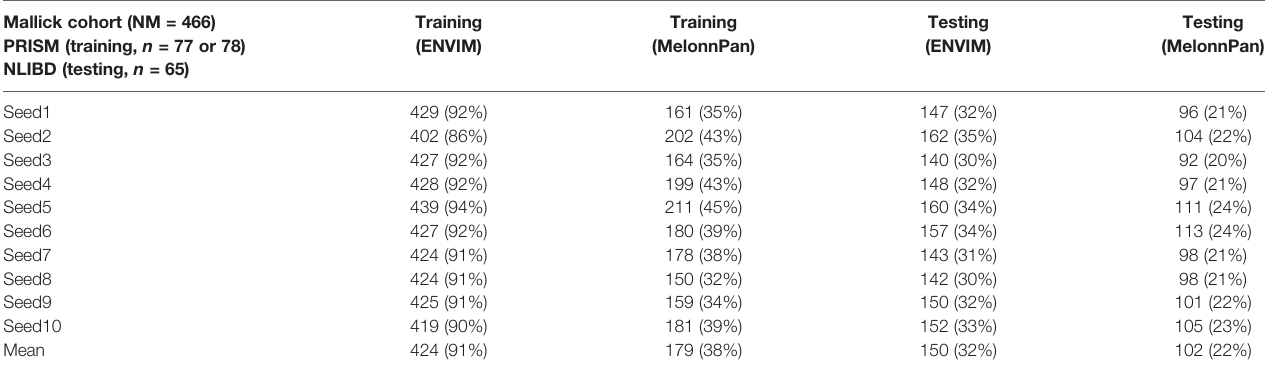
TABLE 4 | Prediction results in Mallick data, when using half of the sample size in the PRISM study as the training set for 10 times and the data in NLIBD study as the testing set. Mallick cohort (NM = 466) PRISM (training, n = 77 or 78) NLIBD (testing, n = 65)